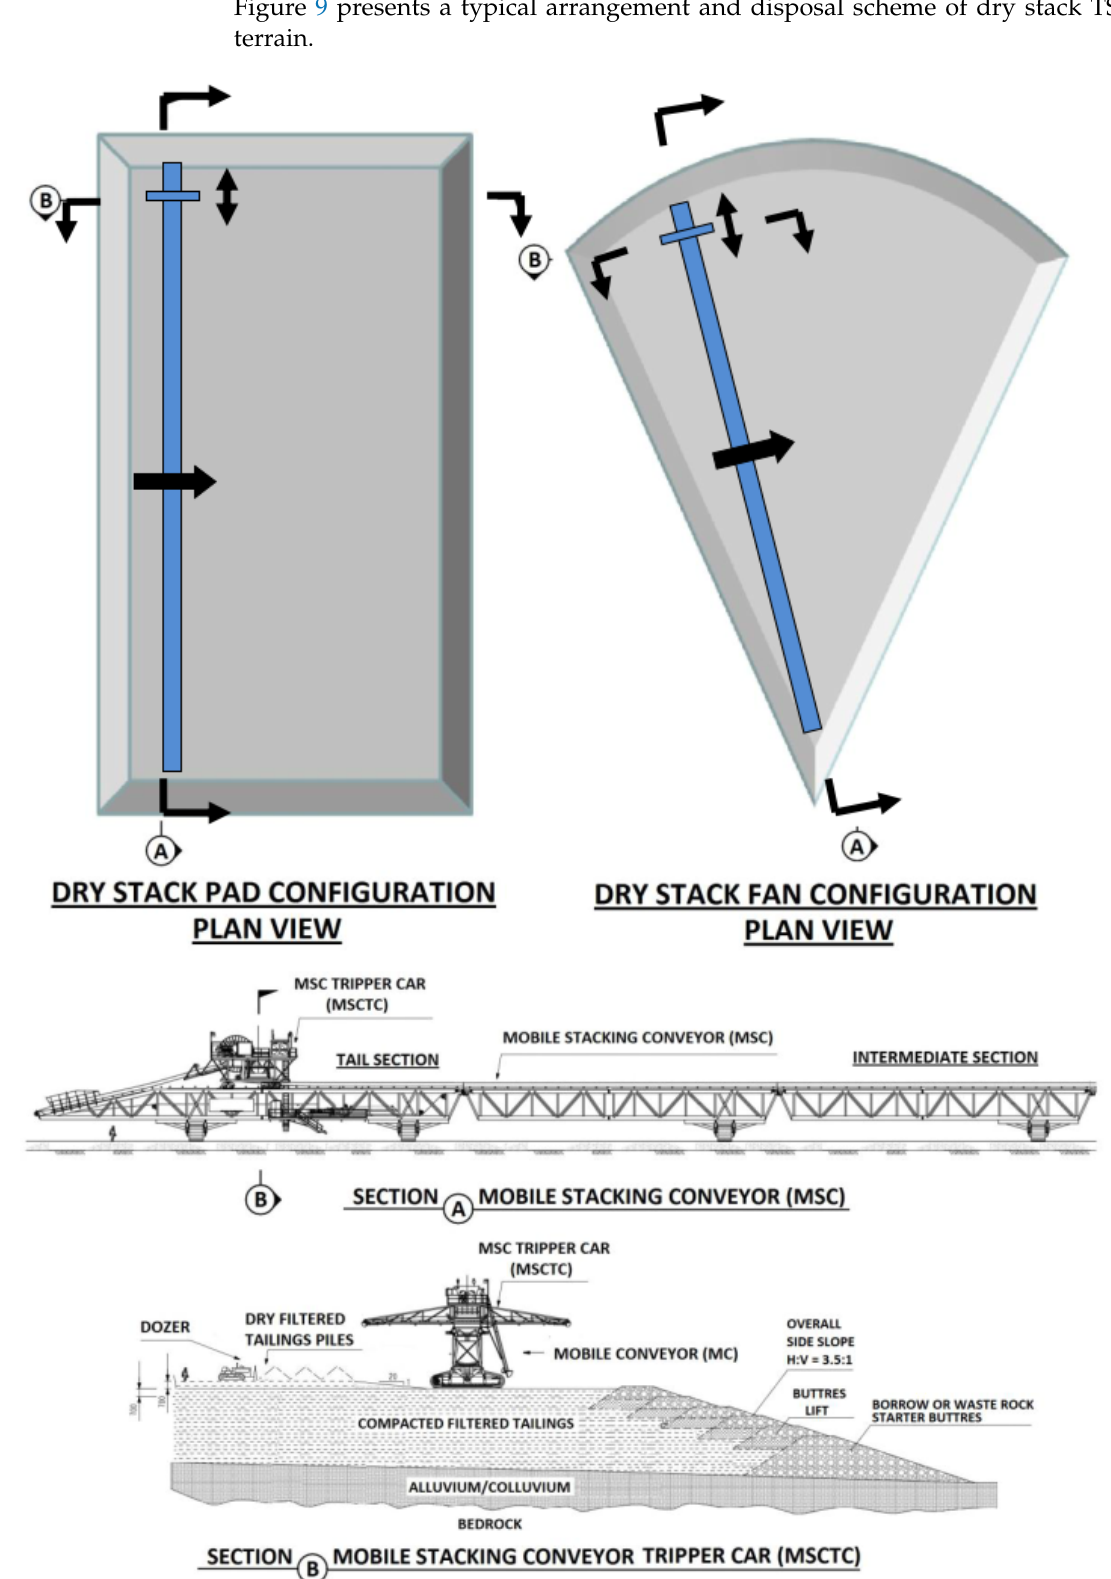
Figure 9. Dry Stacked TSF Disposal Scheme with MSC–Construction Method [11].